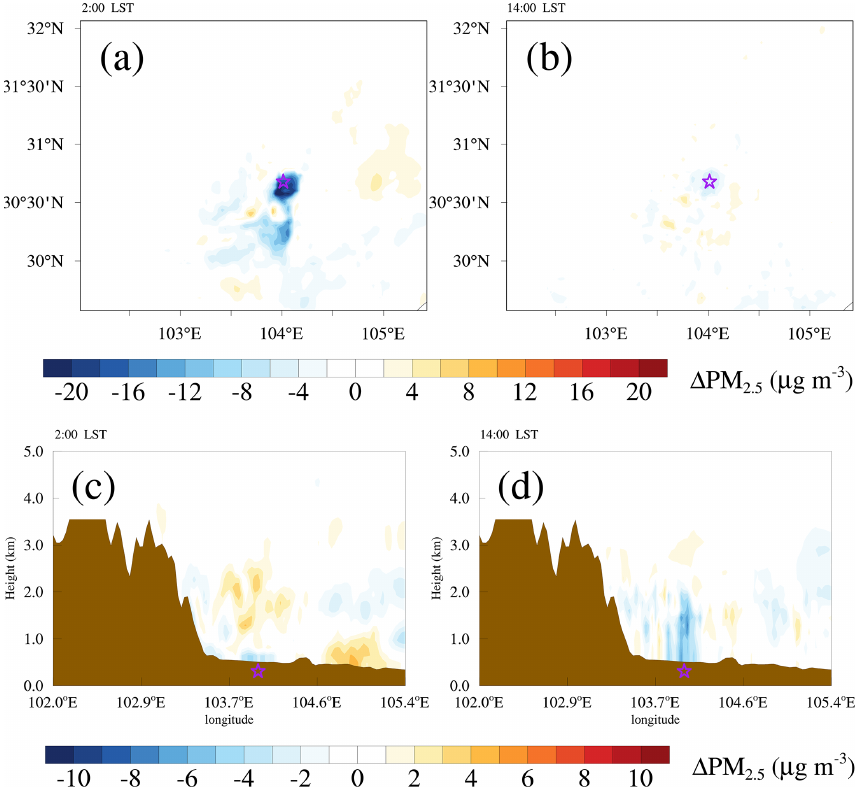
Figure 9. Panels (a) and (b) present the horizontal distributions of the differences in PM 2 . 5 at the lowest model level at 02:00 and 14:00LST, respectively. Panels (c) and (d) present the east–west vertical cross sections of the difference in PM 2 . 5 at 02:00 and 14:00LST, respectively. Purple stars show the location of Chengdu. Brown shaded areas represent the terrain. These results are the difference between the monthly average of the Jan_Base and Jan_noCD simulations (Jan_Base minus